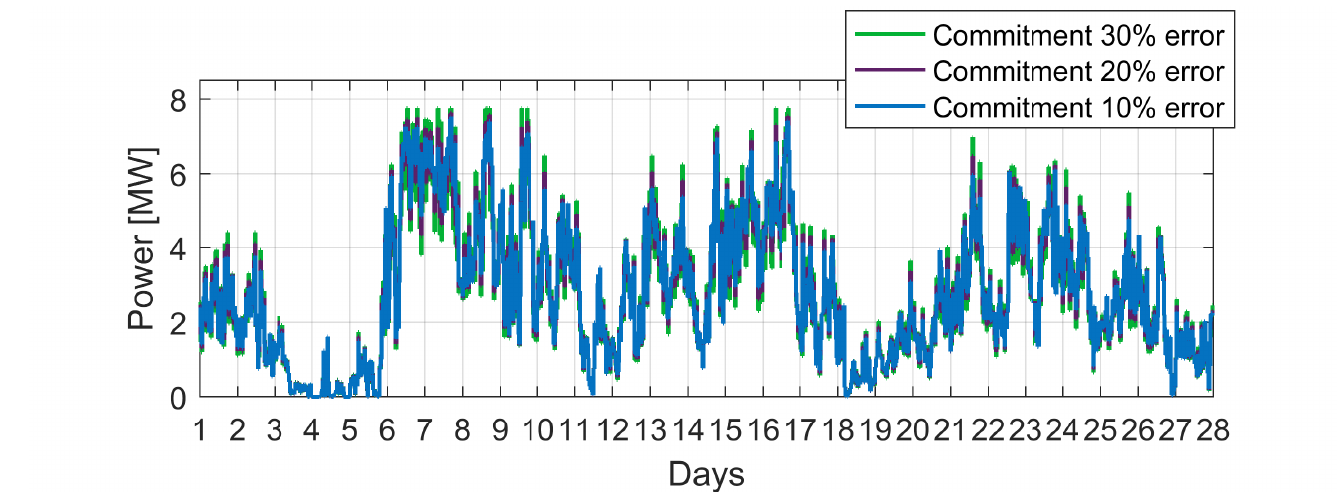
Figure 23. Commitment profiles, 28-day